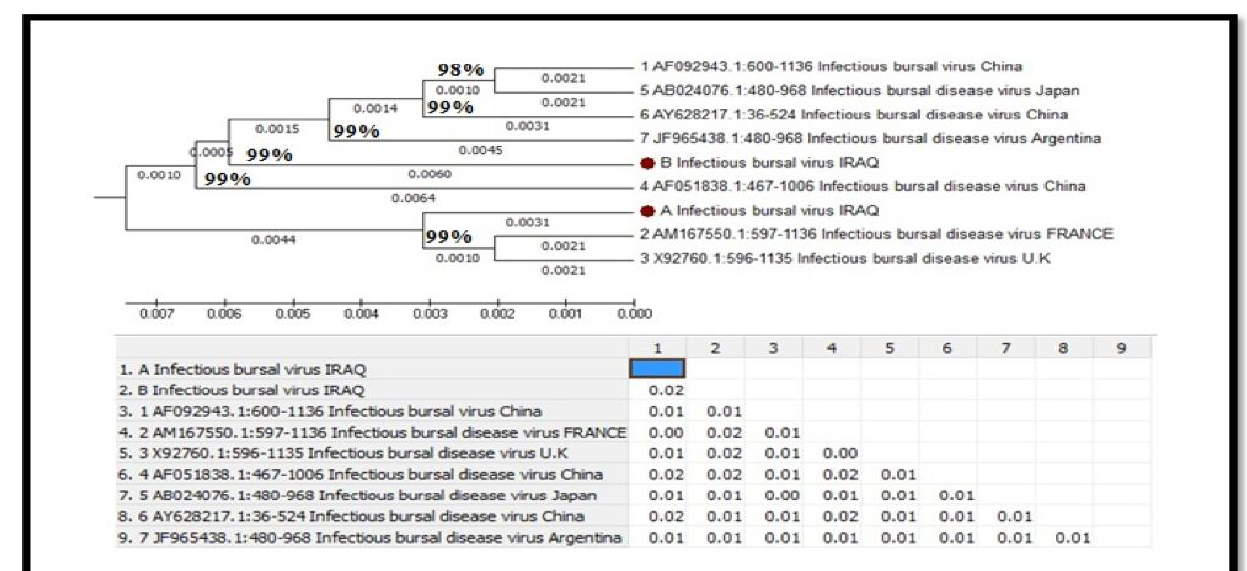
Figure 4. Phylogenetic tree of VP 2-3-4 of two Iraqi isolates